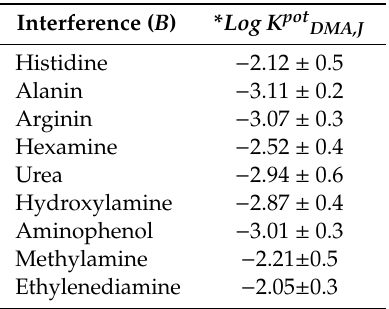
) of DMA membrane sensors plasticized with o -NPOE DMA , B